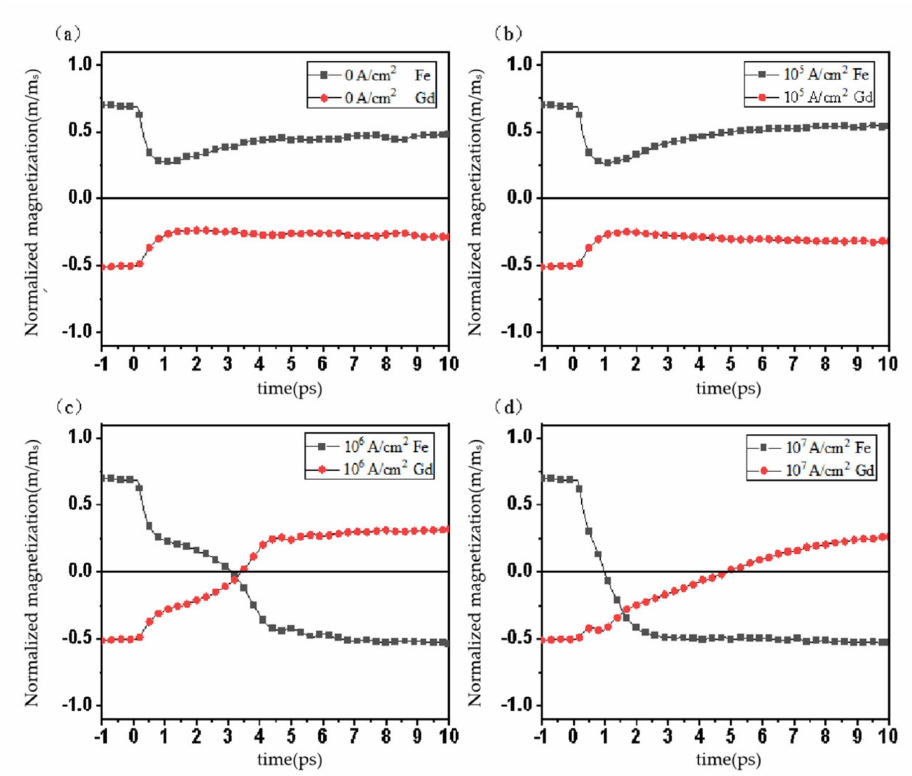
Figure 5. Time-resolved magnetization dynamics process of two sublattices at different current densities. For the situation ( a , b ), the magnetization of Fe and Gd is not reversed. The magnetization of two sublattices switching at the same time almost in ( c ). The switching time of Gd magnetization lags about several picoseconds behind Fe in ( d ). ( a ) The injection current density is 0 A/cm 2 ; ( b ) the injection current density is 10 5 A/cm 2 ; ( c ) the injection current density is 10 6 A/cm 2 ; ( d ) the injection current density is 10 7 A/cm 2 .